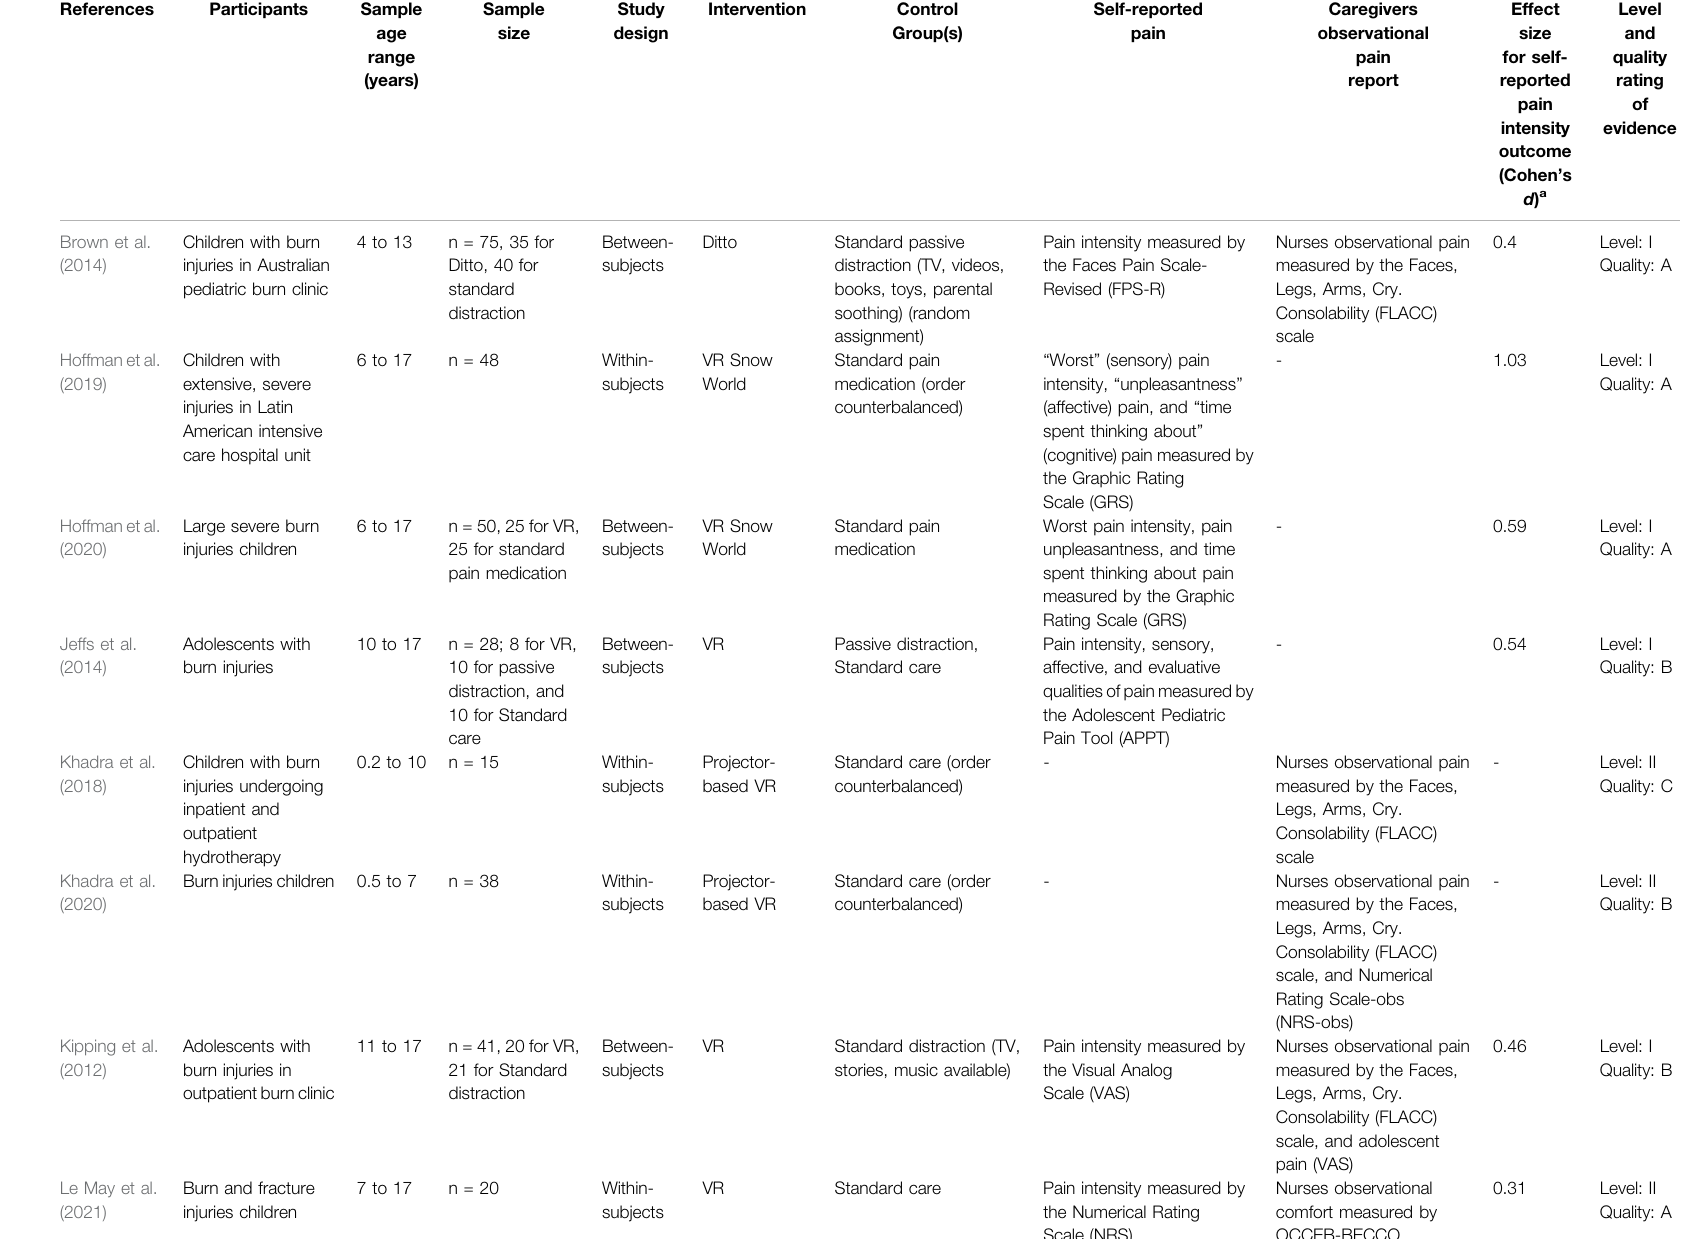
TABLE 2 | Descriptive information from the studies on the effect of VR on pediatric burn